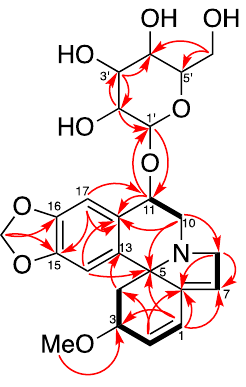
1 H- 1 H COSY ( − ) and key HMBC ( → ) correlations of Compound 1 Figure 2. 1 H- 1 H COSY (−) and key HMBC ( → ) correlations of Compound 1 . Figure 2.